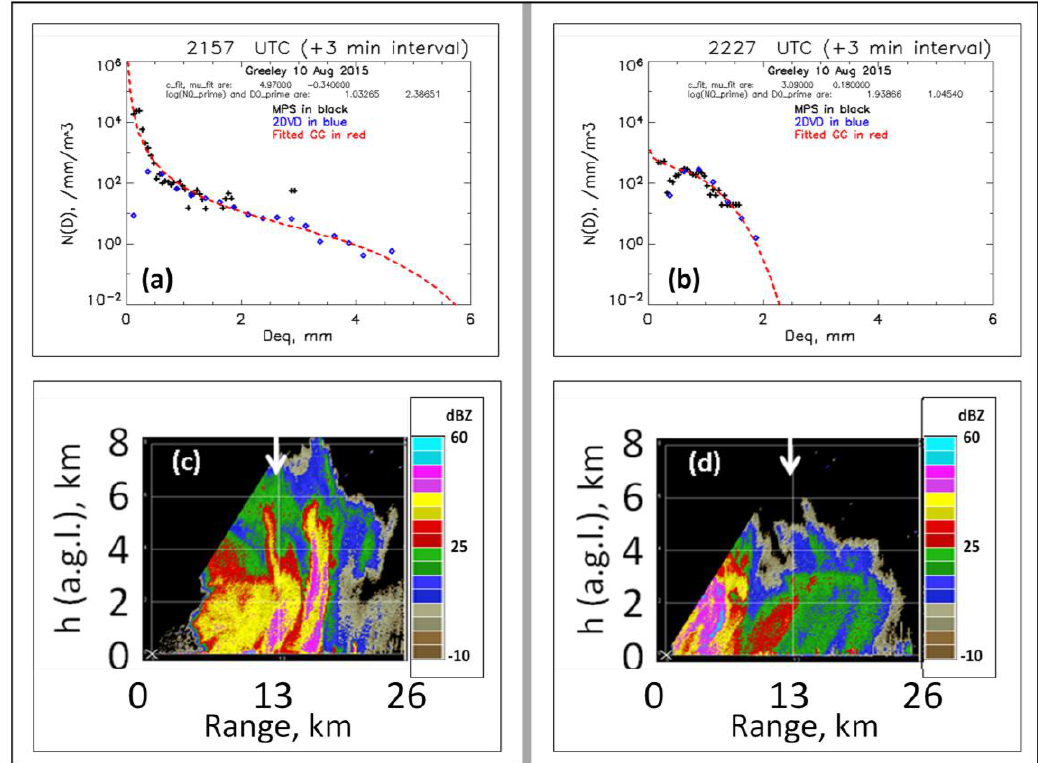
Figure 2. ( a ) Three-minute raindrop size distributions (DSDs) from the meteorological particle spectrometer (MPS) (black) and 2D-video (2DVD) (blue) together with the fitted generalized gamma (GG) curve (red) for the 10 Aug 2015 event at GXY during a convective period (21:57 UTC); ( b ) same as ( a ) but for a more stratiform rain period (22:27 UTC); ( c ) the CHILL S-band RHI scan of radar reflectivity over the instrument site (at 13 km range marked by white arrow) corresponding to ( a ); ( d ) CHILL RHI scan corresponding to period (b).